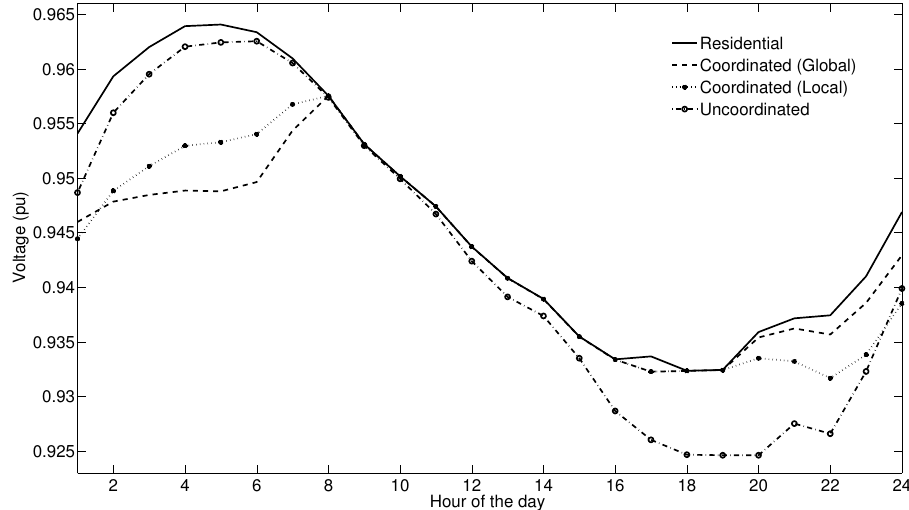
Figure 22. Voltage profiles for Node 840 under coordinated and uncoordinated